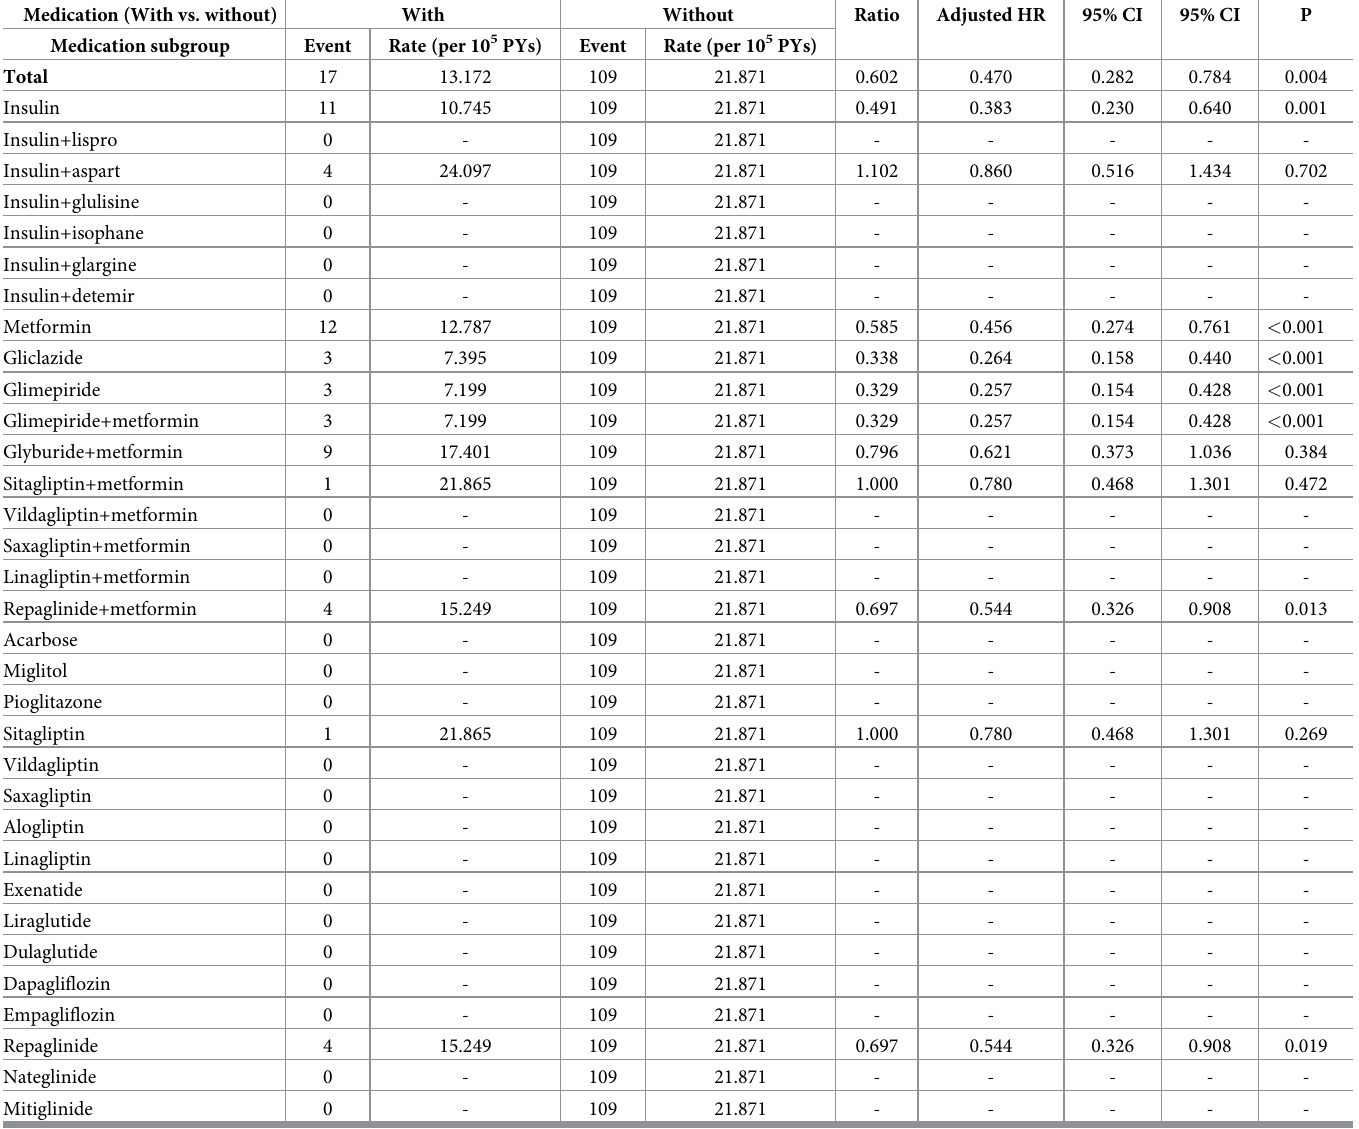
Table 3. Factors of endogenous endophthalmitis stratified by medication subgroup and evaluated using cox regression. Medication (With vs.